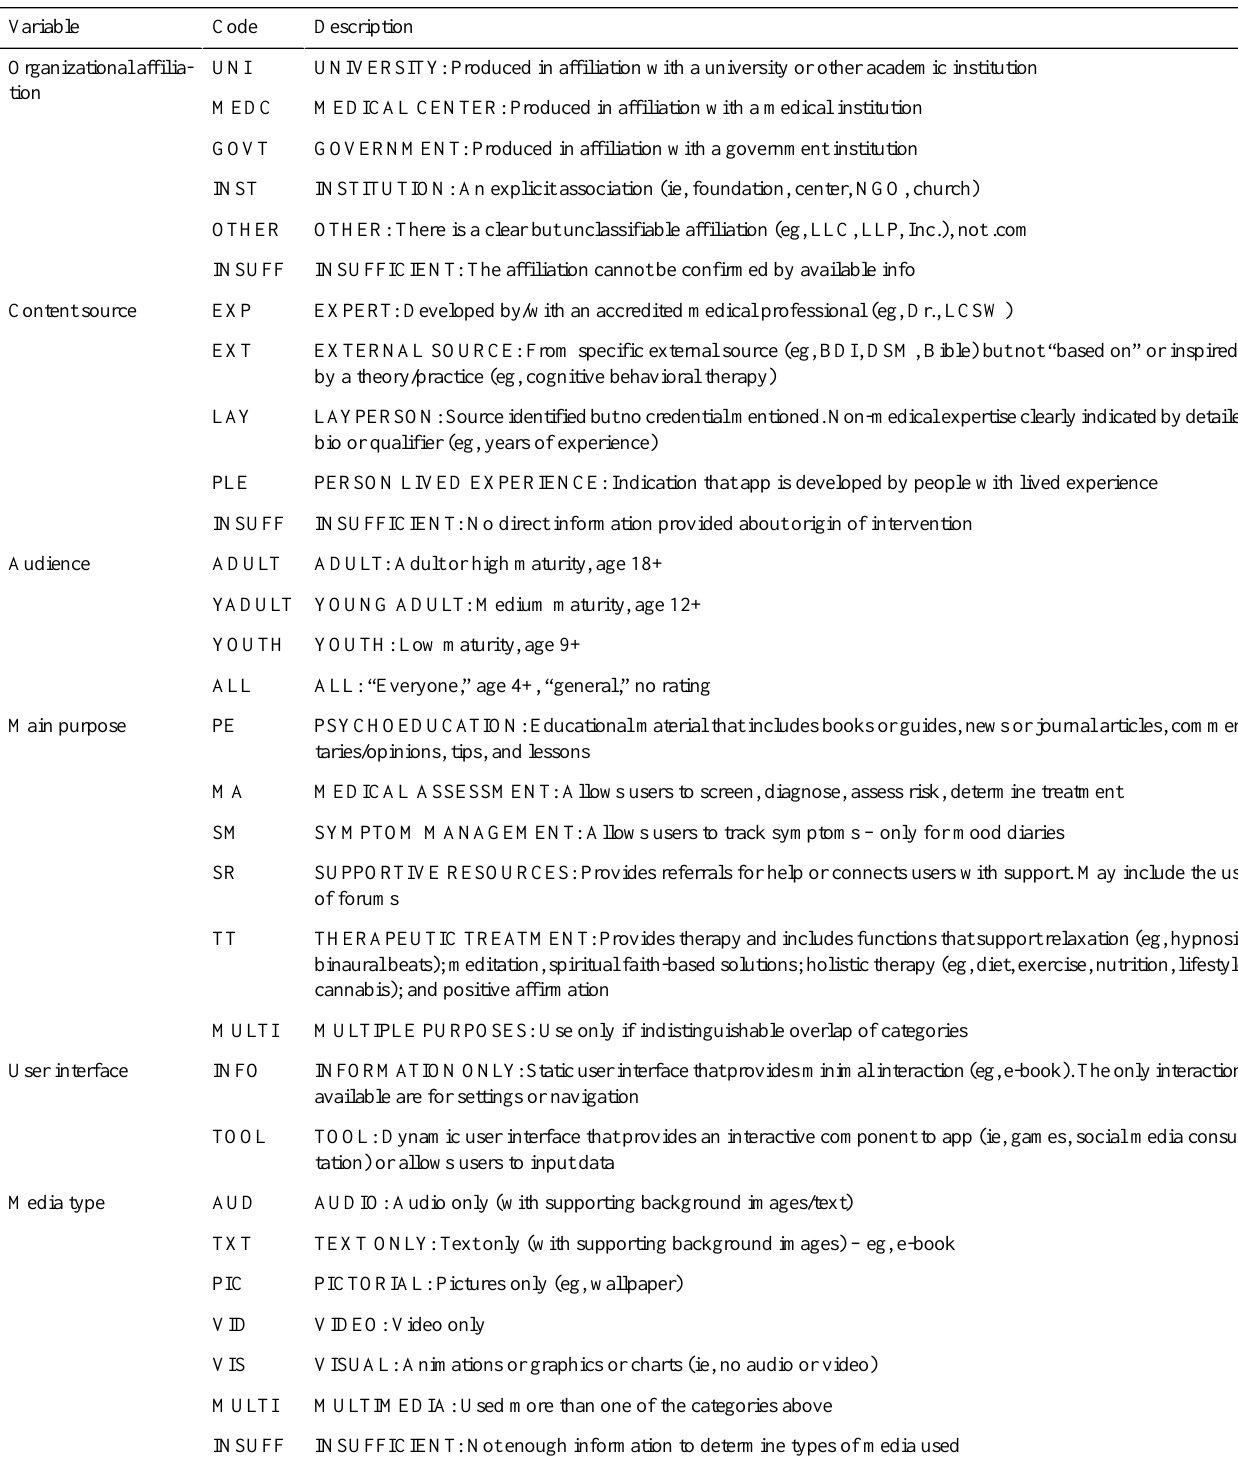
Table 1. Final codebook for content